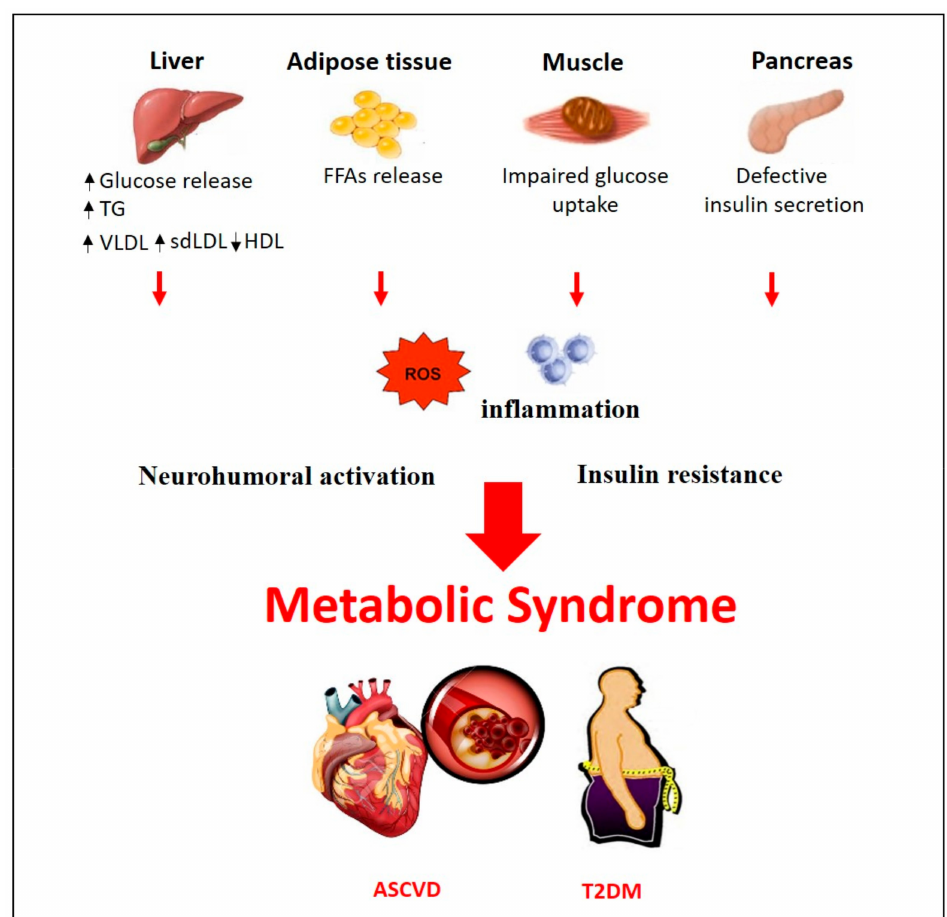
Figure 1. Pathogenesis of Metabolic syndrome. Pathophysiological mechanisms in metabolic syndrome. ASCVD, Atherosclerotic Cardiovascular Disease; FFAs, Free Fatty Acids; HDL, High Density Lipoprotein; sdLDL, small dense low-density Lipoprotein; TG, Triglycerides; T2DM, Type 2 Diabetes Mellitus; VLDL, very-low-density